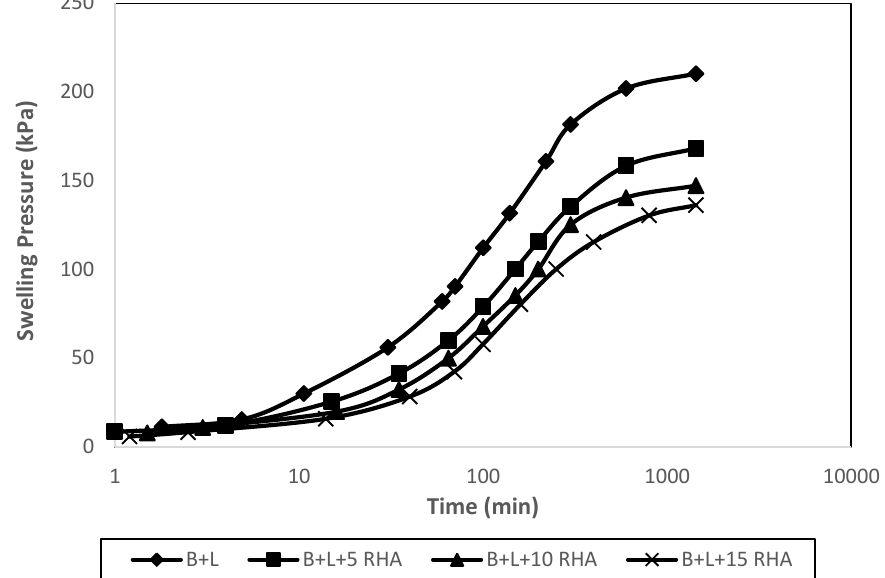
Figure 3. The effect of RHA on swelling pressure of soil stabilized with lime measured immediately after mixing